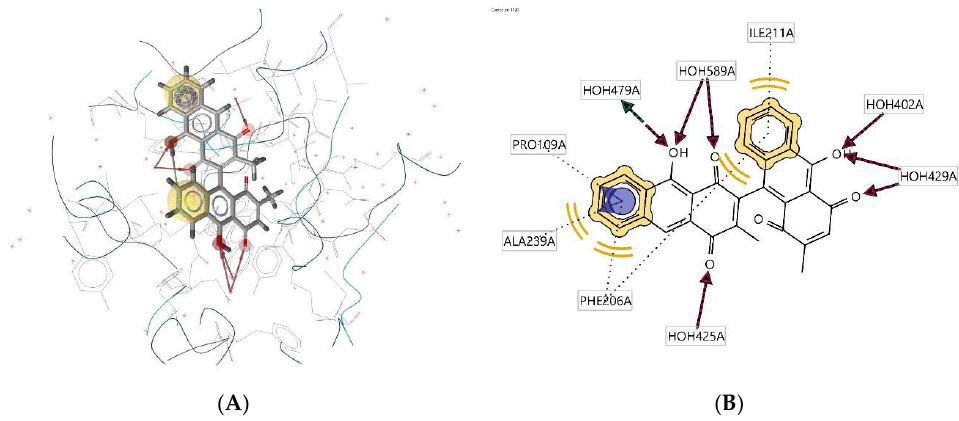
Figure 13. Ligand 132D interacts with the macromolecule. ( A ) 3D view of pharmacophore at the macromolecule binding site. ( B ) 2D view of pharmacophore. Pharmacophore features: hydrophobic interactions (H), yellow; hydrogen bond acceptor (HBA), red; hydrogen bond donor (HBD), green; aromatic (AR) interaction, purple.